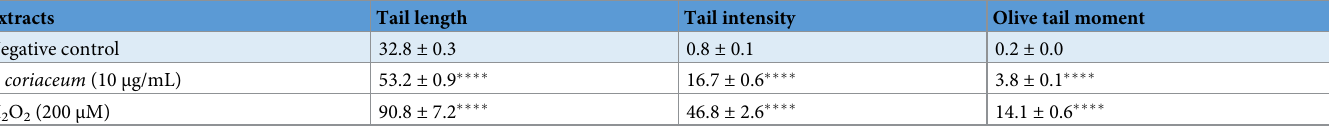
Data are expressed as mean ± SEM of three independent experiments (n = 3). For each experiment, at least 100 comets were scored. Asterisks represent significant differences between treated and untreated cells,